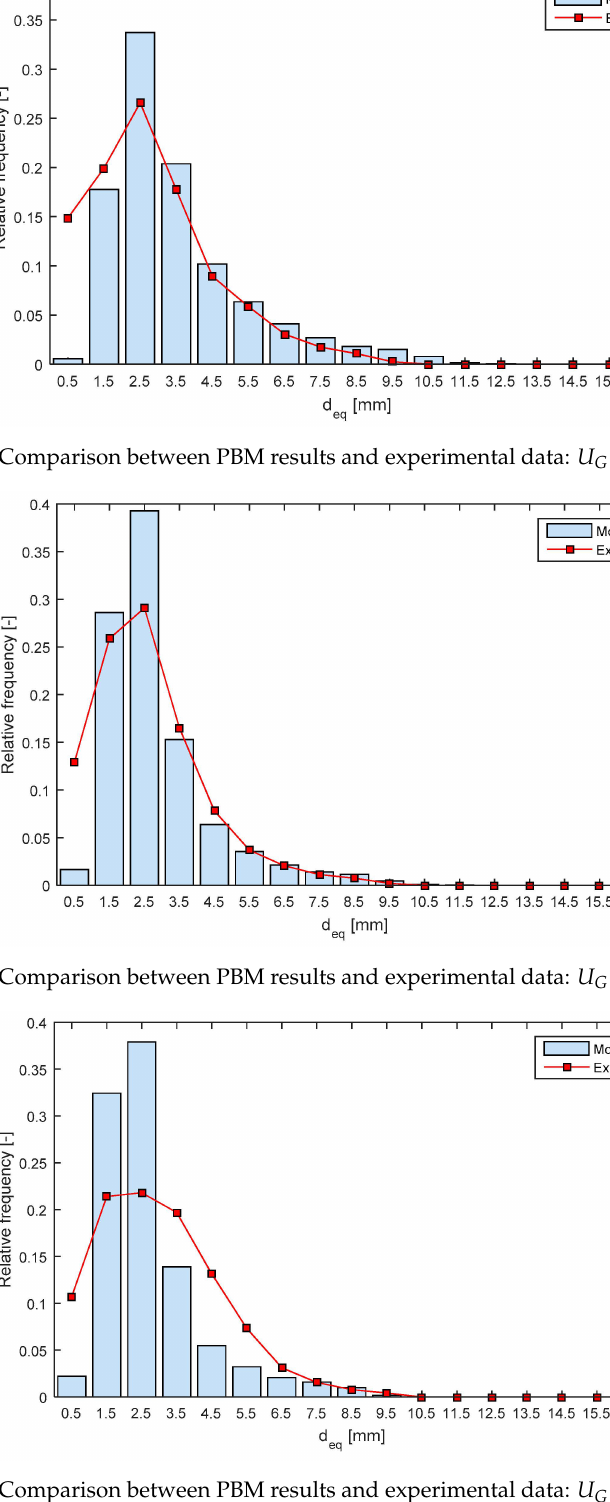
Figure 6. Comparison between PBM results and experimental data: U G = 0.0188